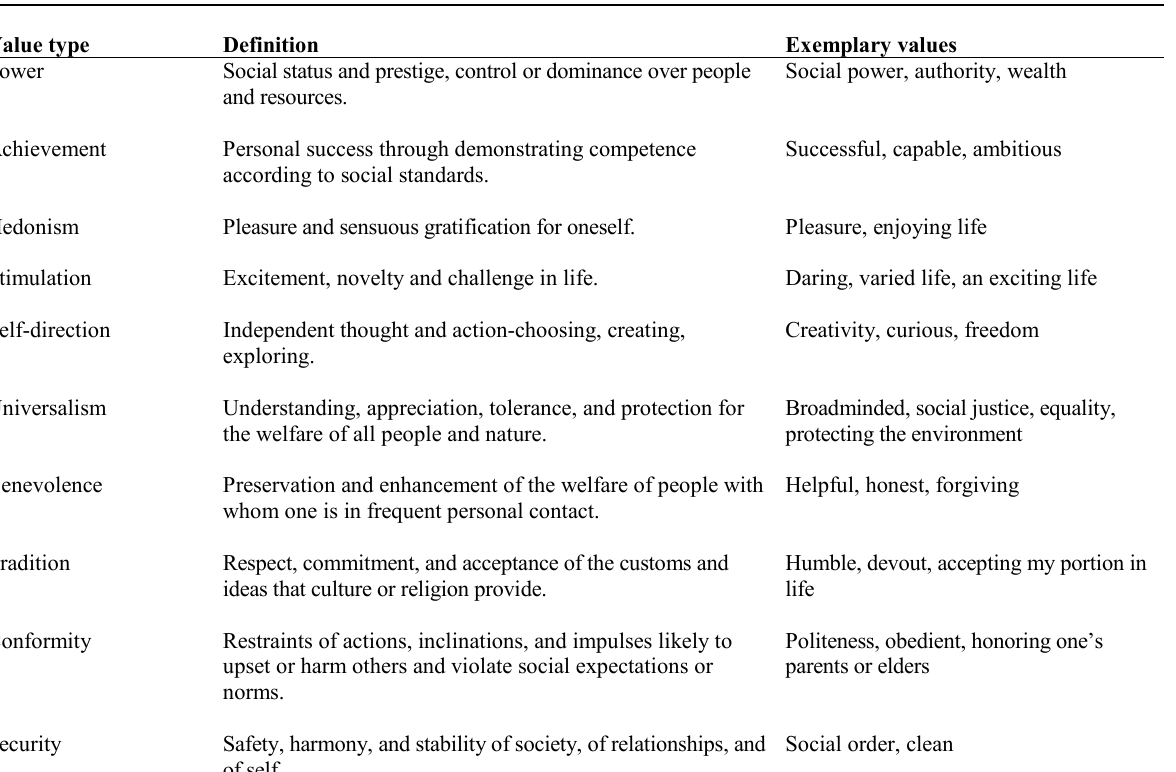
Table 1: Value types in Schwartz’s value